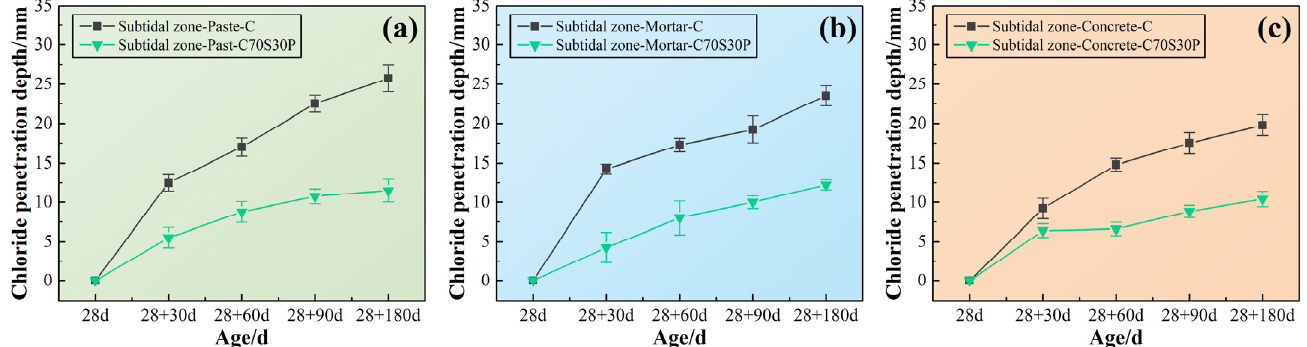
Figure 19. The chloride ions’ penetration depth of CBRM serving in the subtidal zone simulated environment. ( a ) CBRM-Paste, ( b ) CBRM-Mortar, and ( c ) CBRM-Concrete.